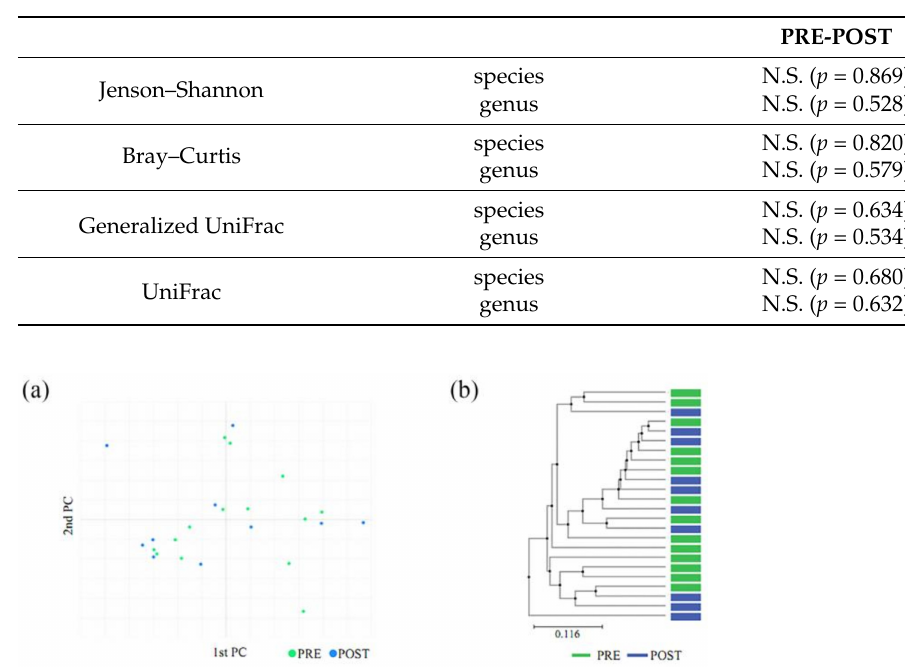
Table 6. Results of PERMANOVA (Beta set-significance was demonstrated by permutational multi- variate analysis of variance) analysis on the salivary microbiome of patients.